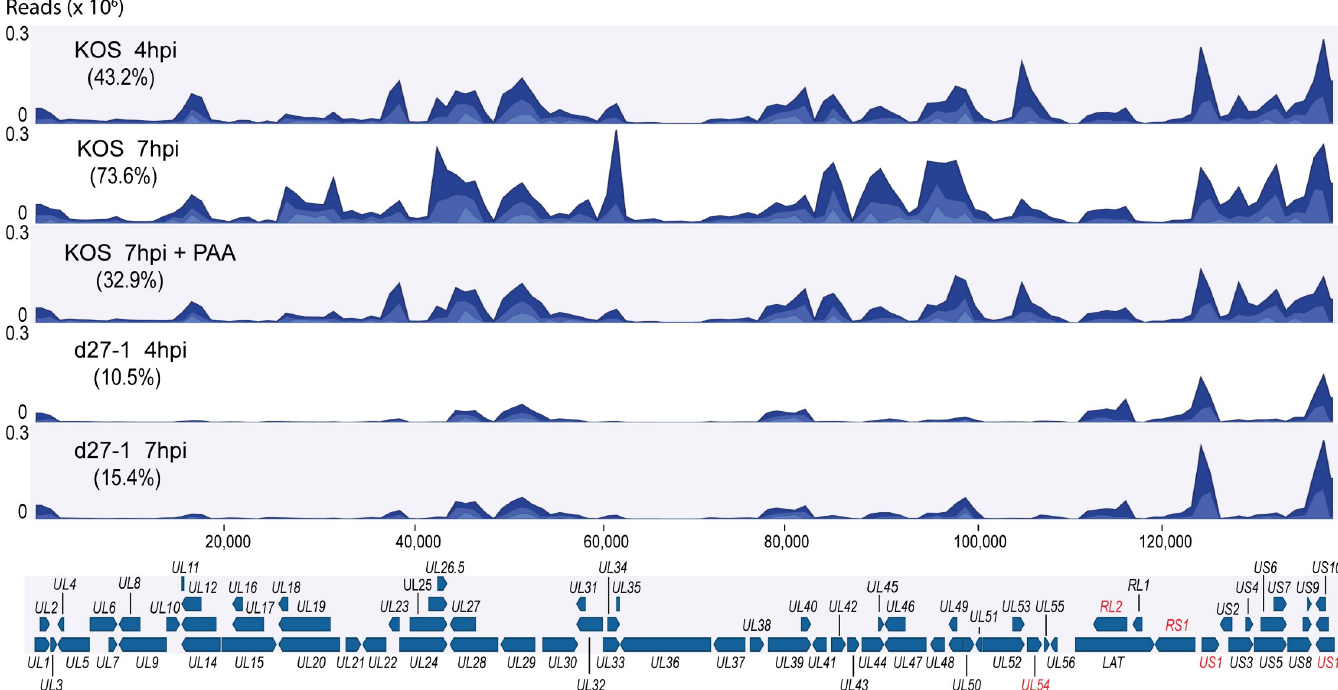
Fig 1. ICP27 deletion reduces expression of non- α viral mRNAs. RNA sequences from HEK-293 cells infected with an HSV-1 ICP27 deletion mutant (d27-1) or its wild-type parental strain (KOS) in the presence of the viral polymerase inhibitor phosphonoacetic acid (PAA) or not at 4 and 7 hpi were aligned to the HSV-1 genome (after removal of terminal repeat sequences, which are represented by internal repeats) and graphed as number of viral reads at each genome location. Genome positions of HSV genes relative to the trimmed genome are shown under the graph. Expression of HSV-1 IE genes including RL2 ( ICP0 ), RS1 ( ICP4 ), US1 ( ICP22 ) and US12 ( ICP47 ) labelled in red was similar between KOS or d27-1 infected cells. IE gene UL54 (ICP27) is not detectable in d27-1 infected cells since the coding region of UL54 was deleted in d27-1.